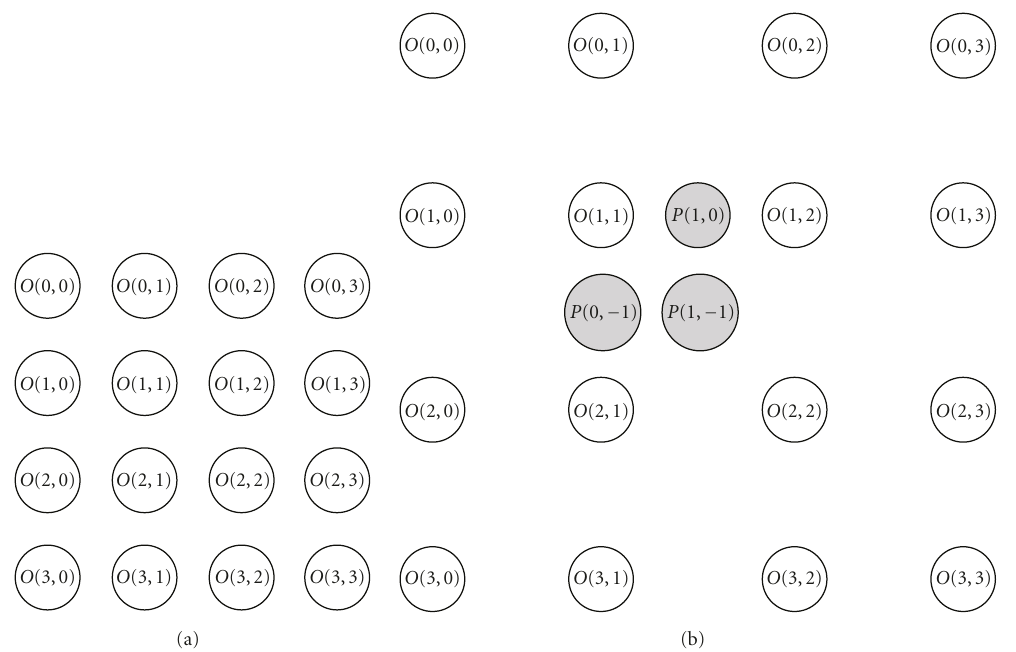
Figure 2: (a) A 4 × 4 sliding block window in the original image. (b) The block after two times